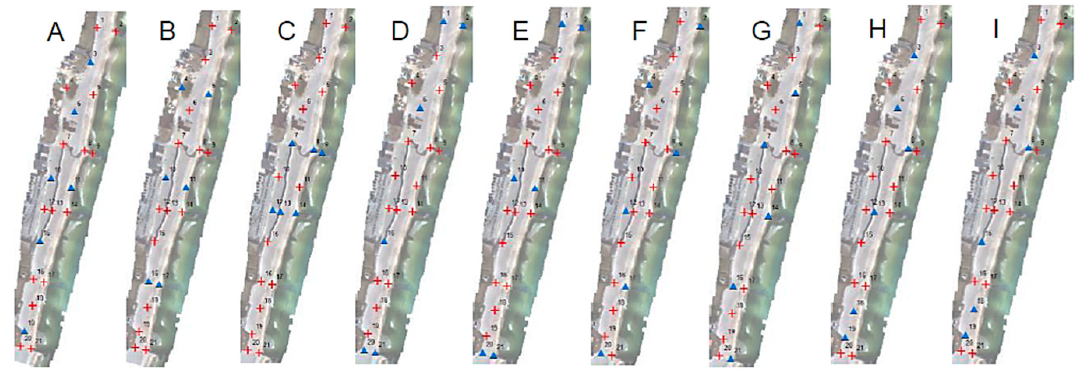
Figure 7. Variations of GCP configurations (GCPs (+) and check points ( ▲ )).